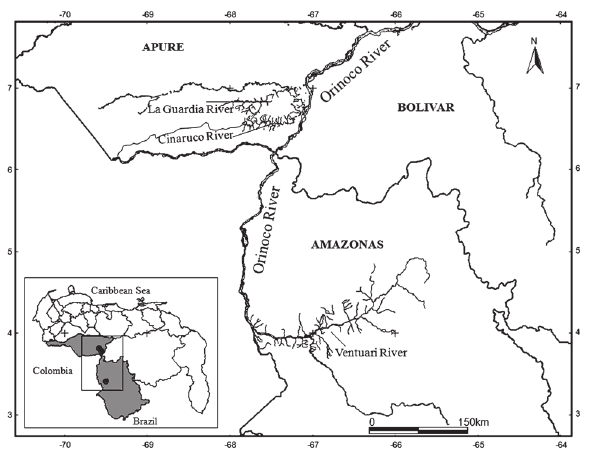
Fig. 1 . Map of Venezuela showing the locations of the three tributaries of the Orinoco River considered in this study: La Guardia, Cinaruco, and Ventuari